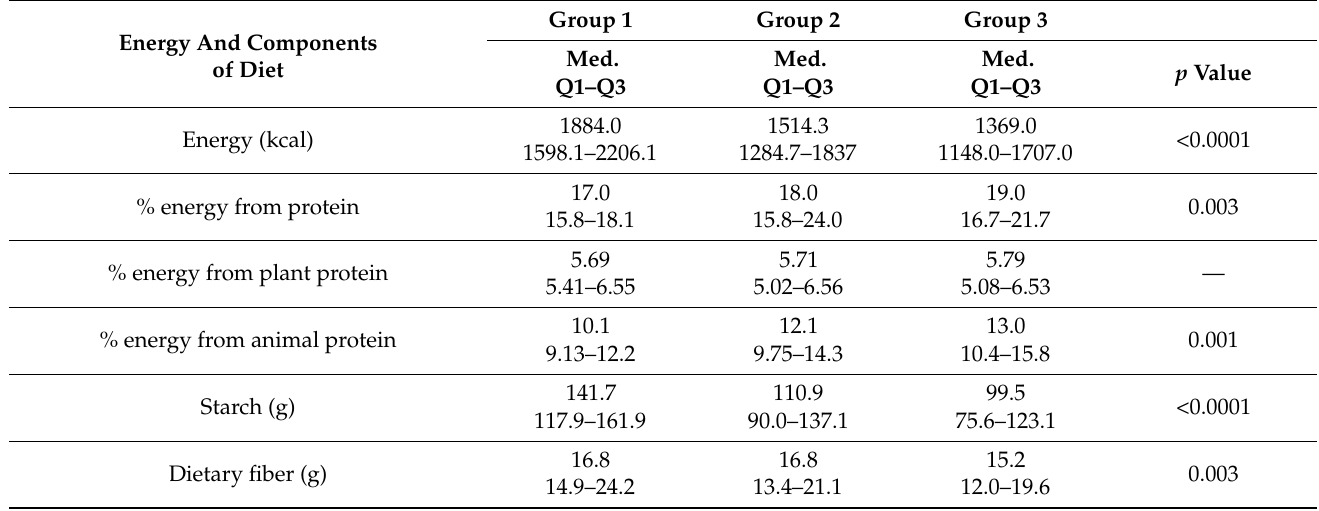
Table 7. Comparison of nutrient intake by study group: Group 1—women with percent body fat (PBF) below 18%; Group 2—women with PBF between 18 and 28%; Group 3—women with PBF above